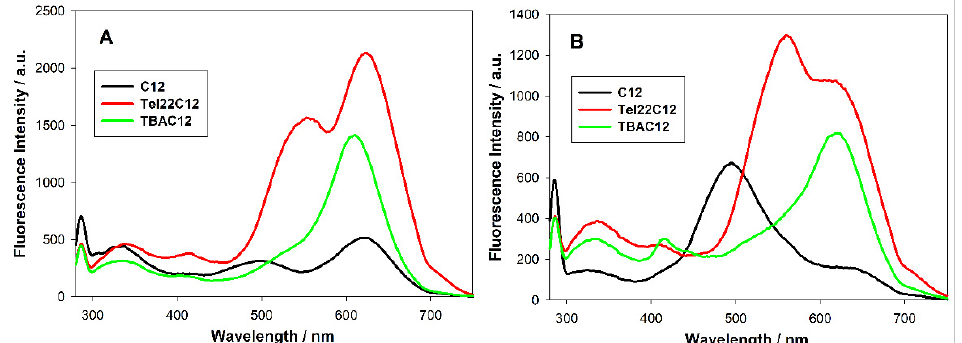
Figure 2. Emission spectra of studied DNA-AgNCs obtained by using different amounts of silver ions: ( A ) cytosine to Ag + ratio 1:1 (Ag + /C); ( B ) sum of cytosine and guanine to Ag + ratio 1:1 (Ag + /CG) for bifunctional templates and cytosine to Ag + ratio 2:1 (Ag + /C) for C12 template. Conditions: 2 µ M probe in 10 mM Tris-acetate (pH = 7.5) after 24 h since silver reduction.